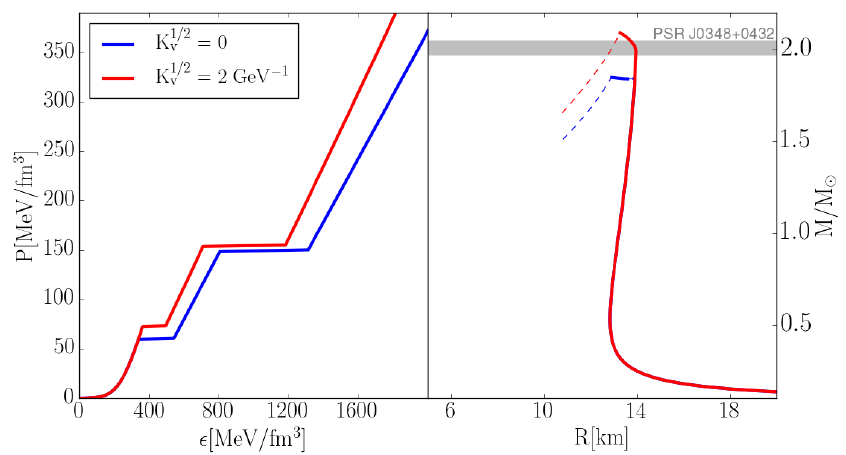
Figure 3. vBag EoS pressure vs. energy density for neutron star matter (left) ; and corresponding mass-radius relations (right) . The grey band represents the possible masses of the PSR J0348+0432 pulsar